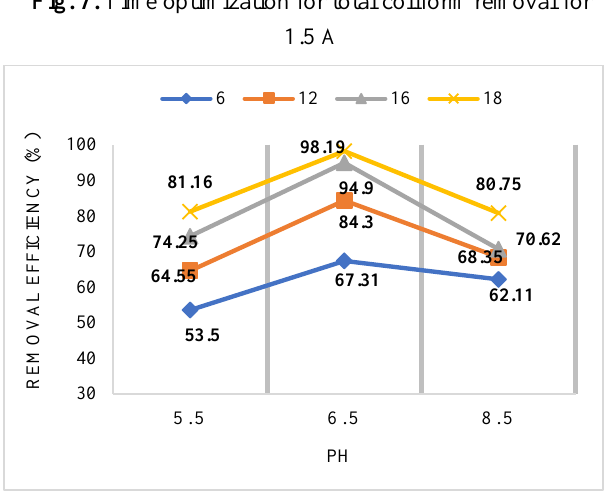
Fig. 8. pH optimization for total coliform removal for 1.5 A